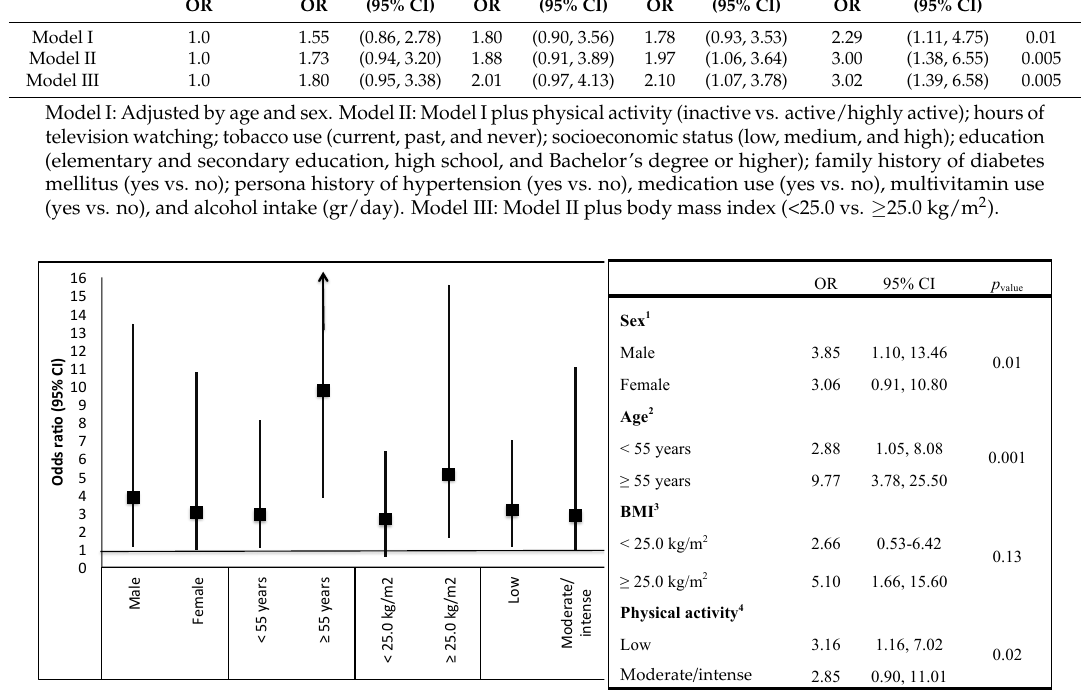
Table 4. Odds ratio (OR) and 95% confidence intervals (CI) for the relation between the dietary inflammatory index and T2DM in the Diabetes Mellitus Survey of Mexico City, 2015. Dietary Inflammatory Index Quintile 2 Quintile 3 Quintile 4 Anti-Inflammatory